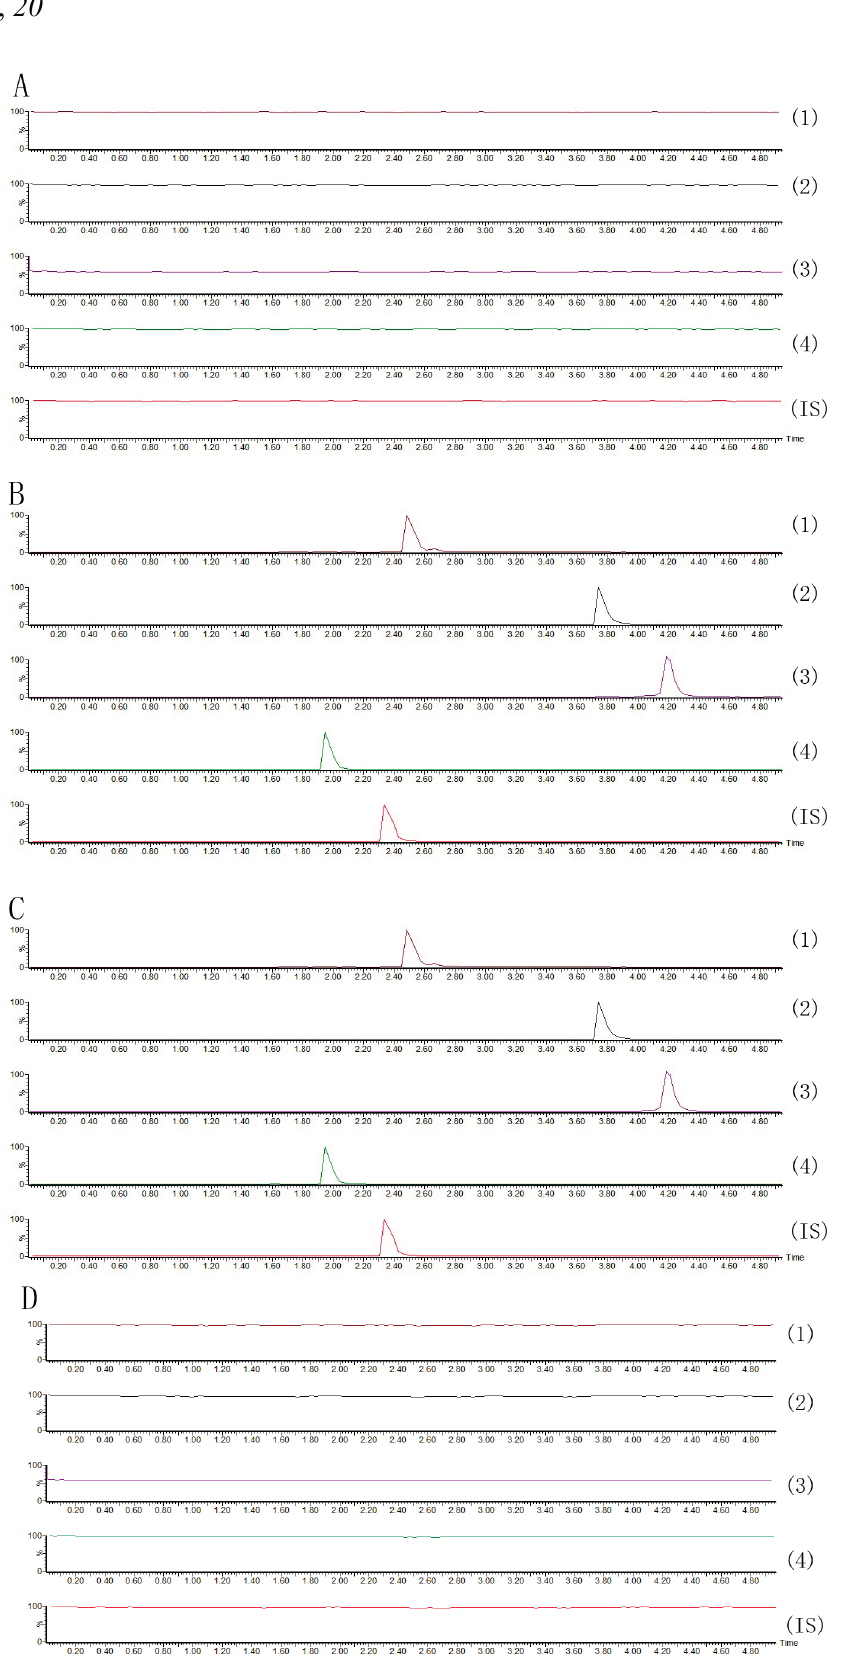
Figure 2. Representatives extract ion MRM chromatograms of compounds 1 – 4 and ginsenoside Re (IS): ( A ) blank plasma; ( B ) blank plasma spiked with each compound; ( C ) plasma sample at 45 min after oral ASE extract; ( D )